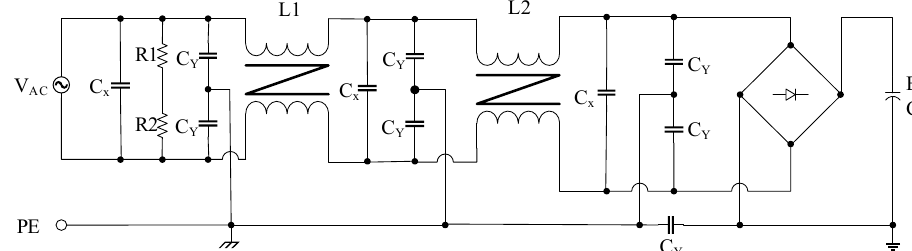
Figure 2. Configuration of the compressor drive developed.